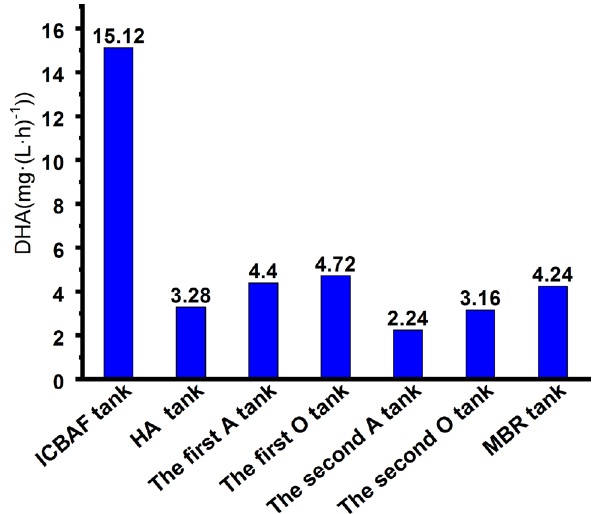
Figure 3. DHA of the biochemical